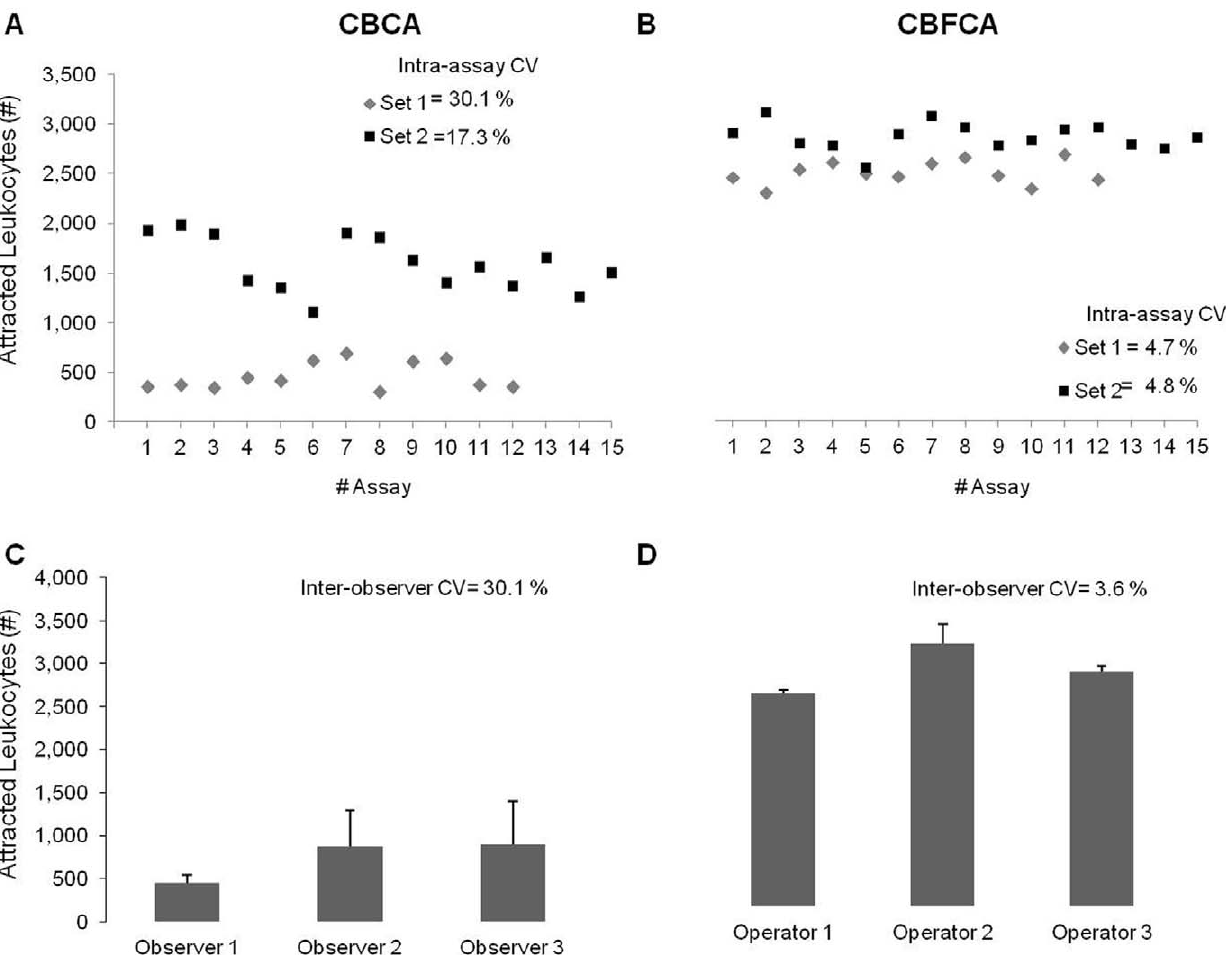
Figure 2. Precision: Intra-assay and inter-observer variation. A&B) Two sets of assays were performed by CBCA or CBFCA, set 1 includes 12 assays (gray diamonds) and set 2 includes 15 assays (black squares). Intra-assay coefficient of variation (CV) in CBCA was higher than in CBFCA in both sets (30.1 and 17.3% vs 4.7 and 4.8%). D&C) Three of these assays were counted by three different observers/operators using microscopy or flow cytometry. The inter-observer CV in CBCA was higher than in CBFCA (30.1 vs 3.6%). Data are shown as means 6 SD of three independent assays counted in triplicate.